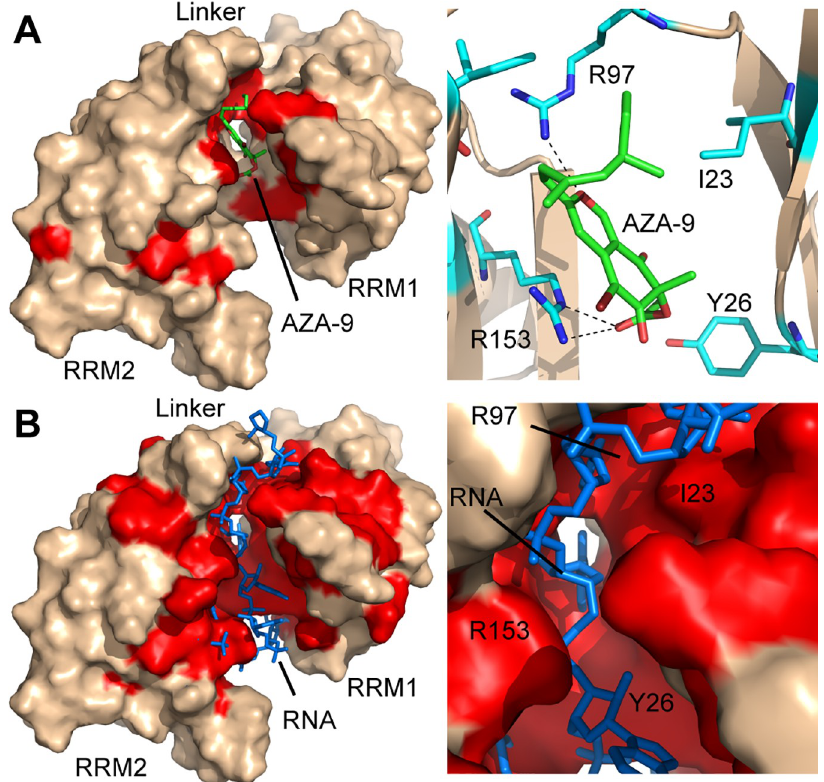
Fig 5. Molecular docking identifies a possible binding pocket for AZA-9 in the RNA-cleft of HuR. (A) Computational model of AZA-9 boundto HuR RRM1/2, with protein shown in surface representation and AZA-9 in sticks. HuR RRM1/2 residues affected in AZA-9 NMR titrations are coloredred. An expandedview of the bindingpocket is shown in the right. Residuesinvolvedin AZA-9 bindingare displayedas sticks, with hydrogen bonds shown as dashed lines. (B) Surface representation of HuR RRM1/2 bound to RNA (sticks) for comparisonwith the AZA-9 model. Residuesaffected upon RNA titrations are highlightedin red. An expanded view of the RNA-pocket is shown in the right. Residues(Y26, K55, L61, R97, R153) perturbedby AZA-9 in the NMR titrations are critical RNA-binding residues.